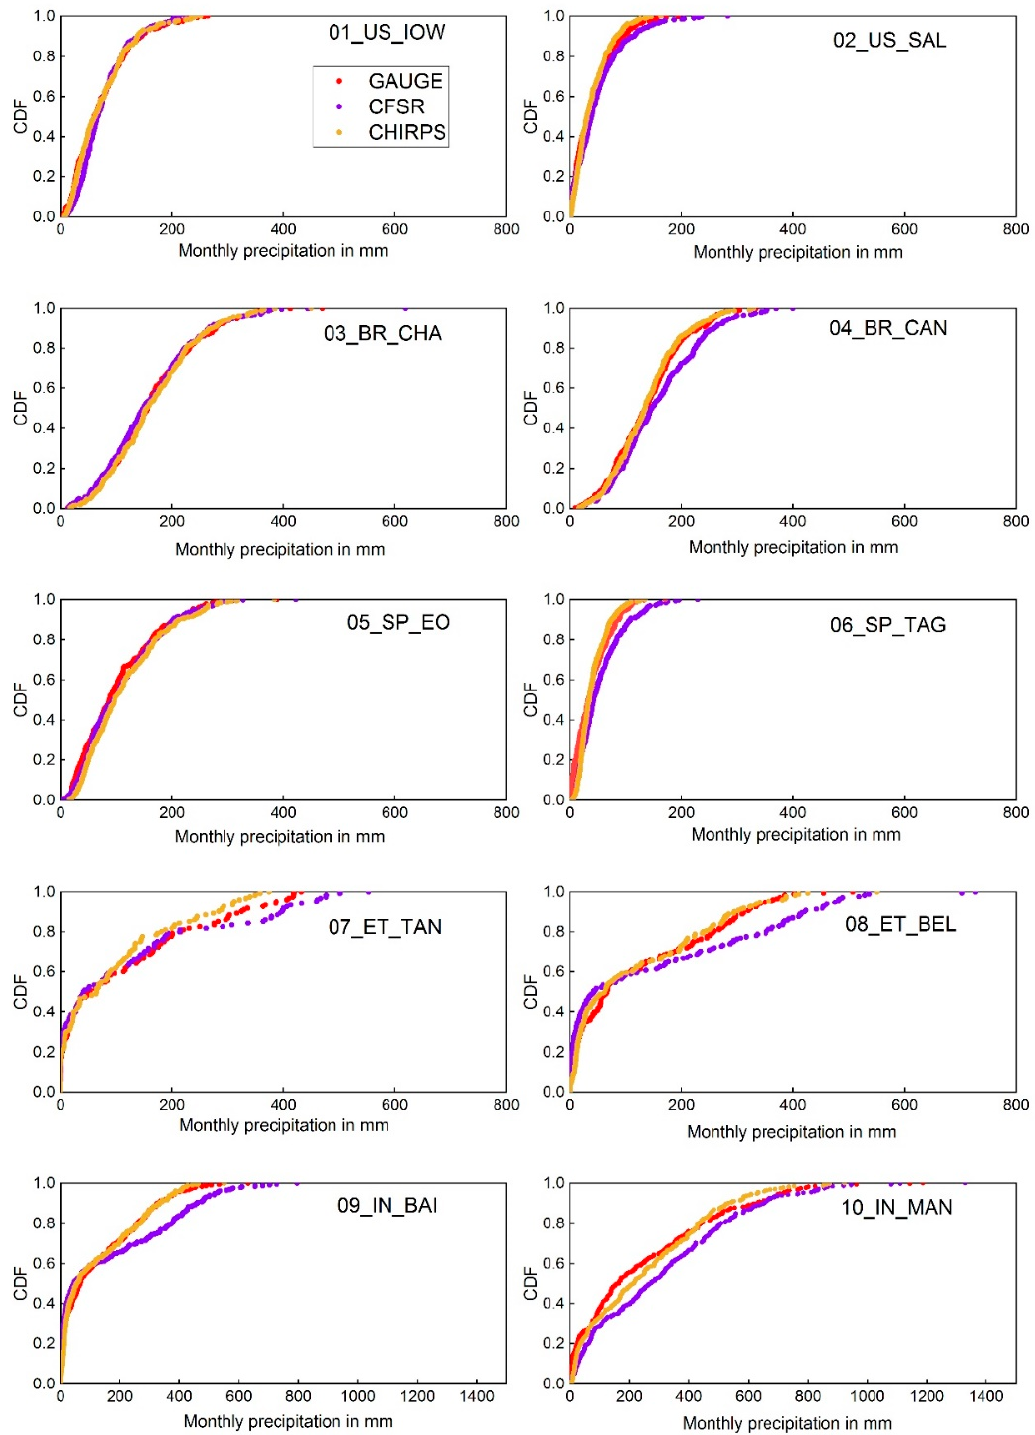
Figure 4. Cumulative distribution of monthly rainfall of the selected watersheds for 1. Gauge 2. CFSR, and 3.